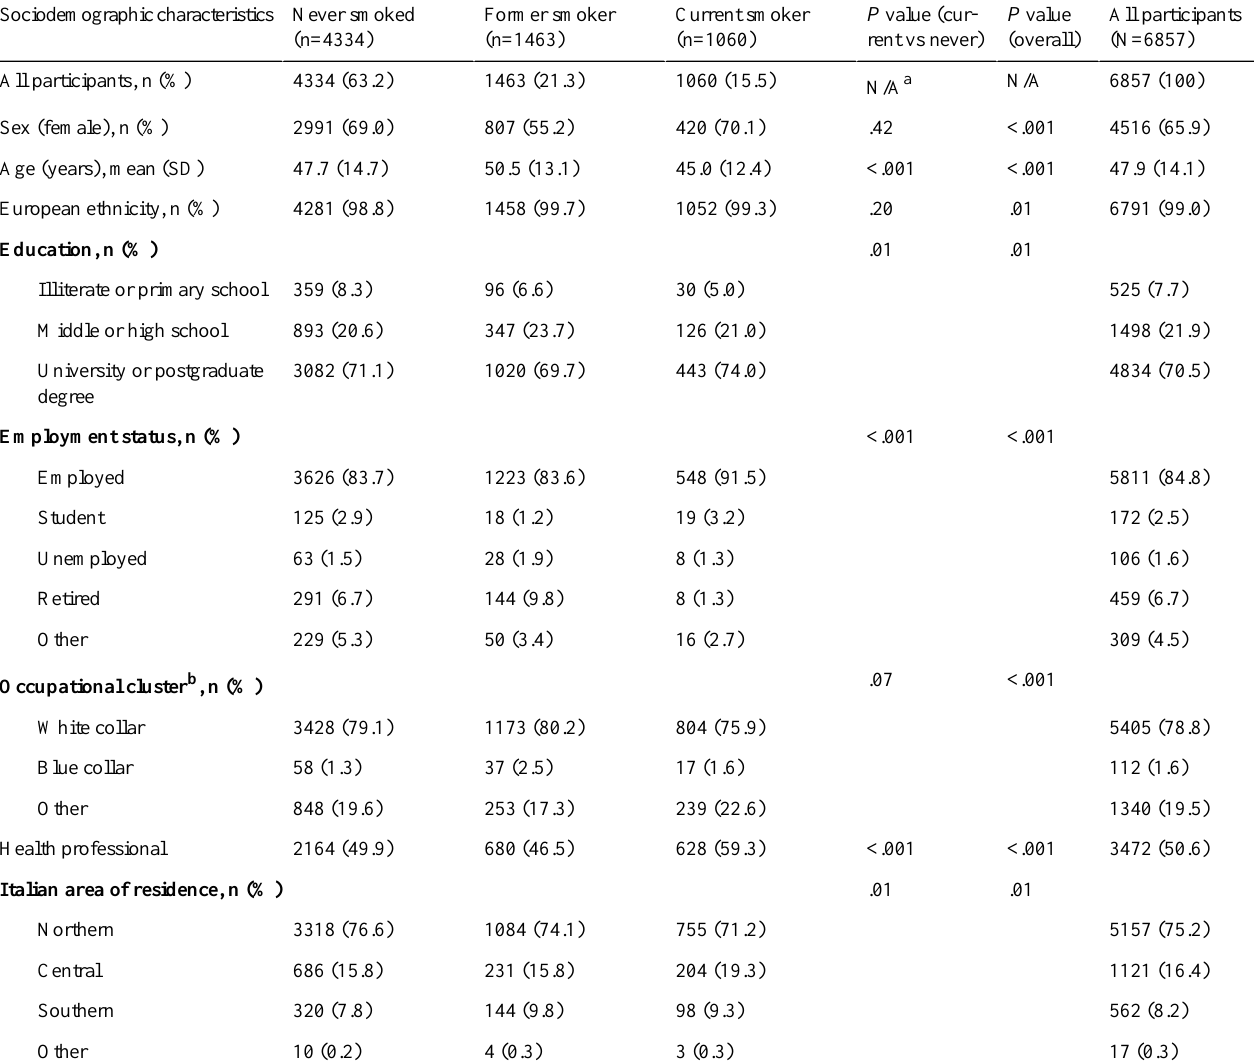
Table 1. Sociodemographic characteristics of study participants with known molecular test results by smoking status in Italy, from April 13 to June 2, 2020